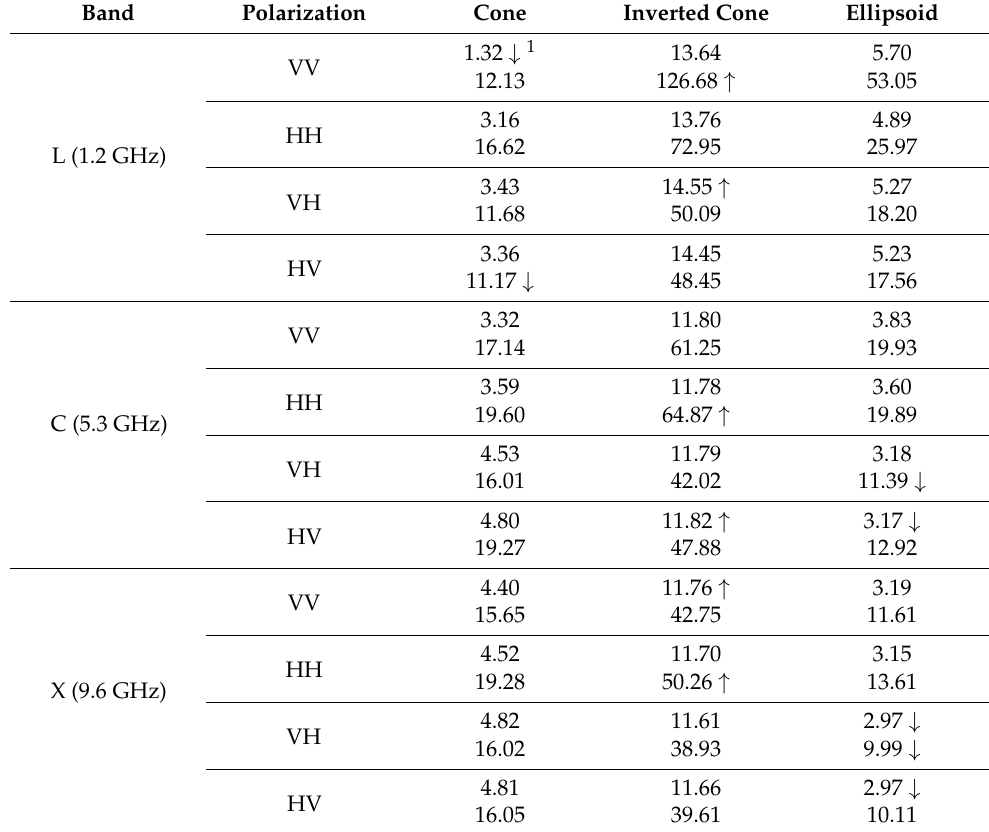
Table 4. µ a and µ r of the simulation results between the three crown shapes studied and the reference cylinder crown shape using canopy A’s parameters as inputs. Band Polarization Cone Inverted Cone